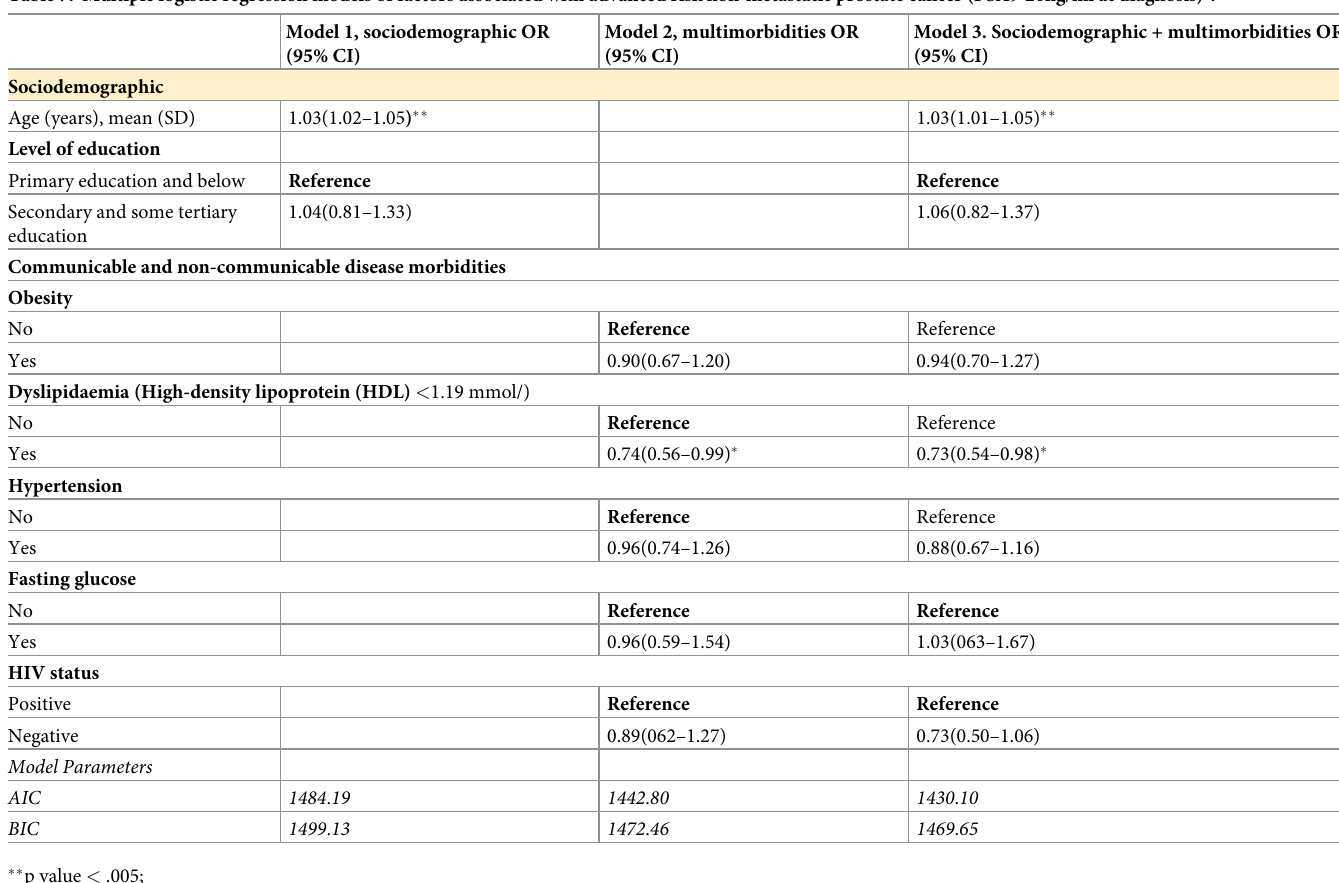
Table 7. Multiple logistic regression models of factors associated with advanced risk non-metastatic prostate cancer (PSA > 20ng/ml at diagnosis) a